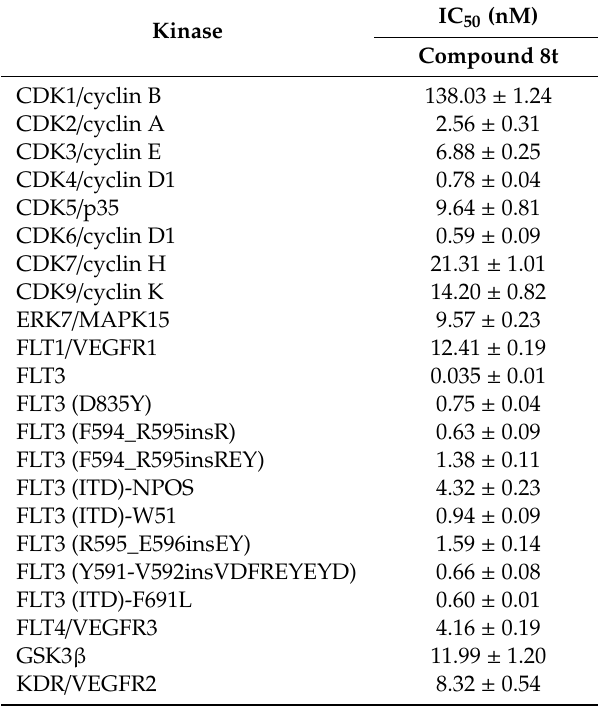
Table 5. Inhibition of compound 8t against CDKs, FLT3s, and other kinases.